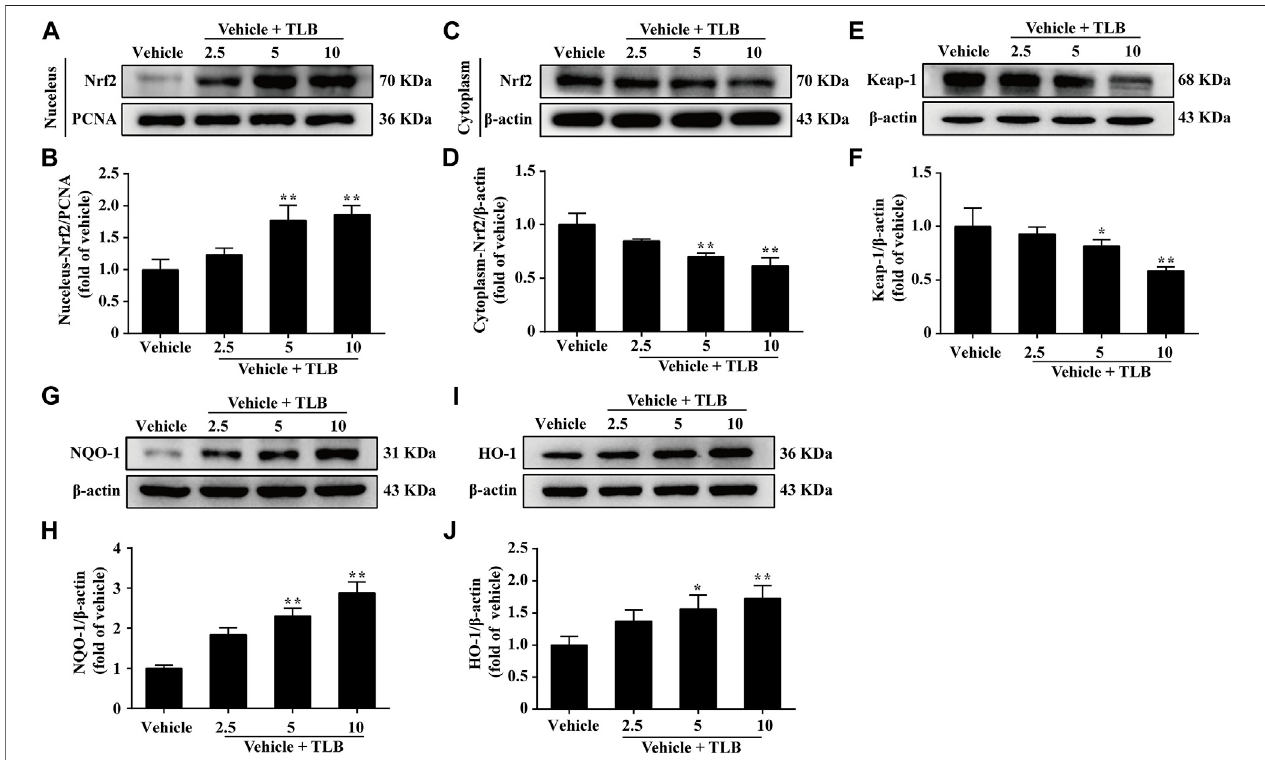
FIGURE 4 | Effect of TLB on Nrf2/ARE signaling pathway on EEIF in mice. (A) Representative Western blots of nucleus-Nrf2. (B) Quantitation of nucleus-Nrf2. (C) Representative Western blots of cytoplasm-Nrf2. (D) Quantitation of cytoplasm-Nrf2. (E) Representative Western blots of Keap-1. (F) Quantitation of Keap-1. (G) RepresentativeWesternblotsofNQO-1. (H) QuantitationofNQO-1. (I) RepresentativeWesternblotsofHO-1. (J) QuantitationofHO-1.Thedatawerepresentedasthe mean ± SEM ( n = 5). * p < 0.05 and ** p < 0.01 vs vehicle